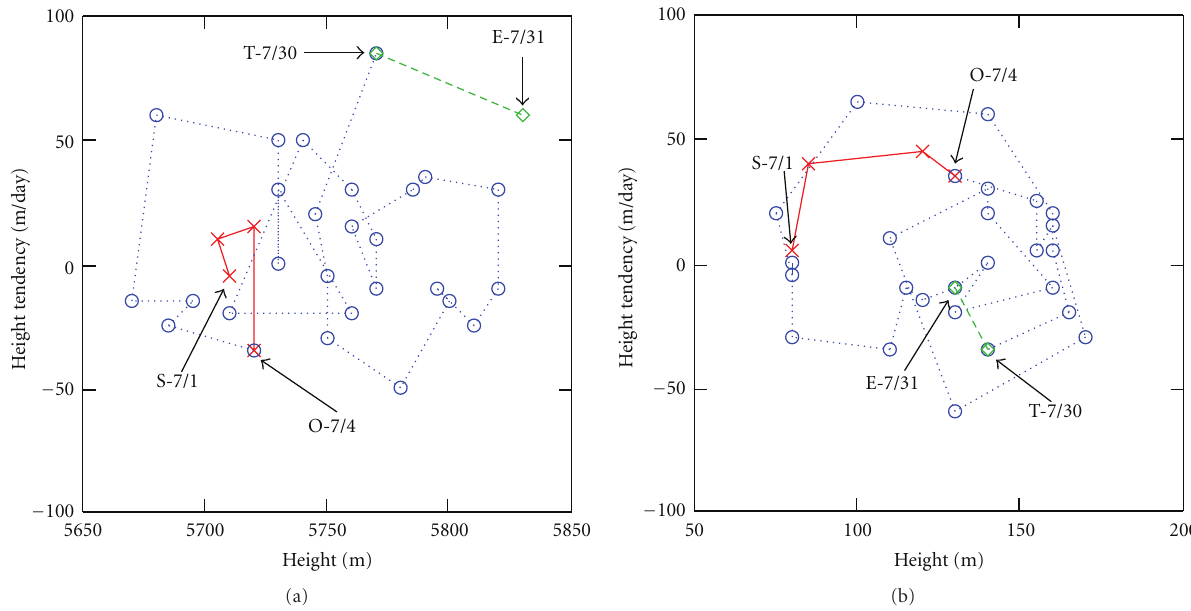
Figure 4: Phase trajectories for the 500-hPa heights in the central part of the blocking region for July 2010 for the (a) planetary-scale, and (b) synoptic-scale, during the preblock (solid, red— X ), the block lifecycle (dots, blue—o), and decay (dash, green—diamond). The trajectory begins at (S) and ends with (E), and the block onset is marked with (O) and termination with (T). The dates are labeled as month/day.